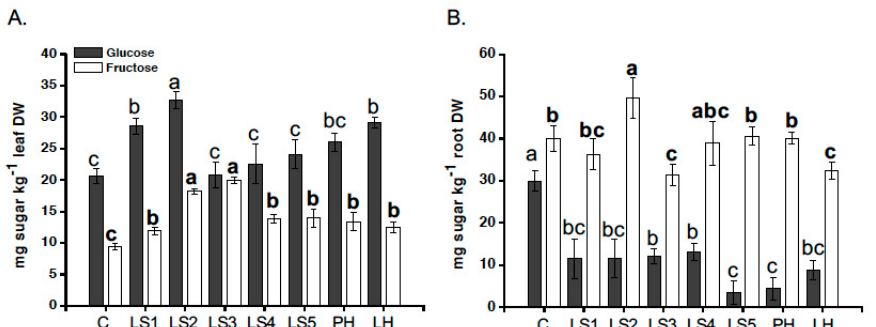
Figure 6. E ff ect of individual humates (Hs) on glucose and fructose accumulation in leaves ( A ) and